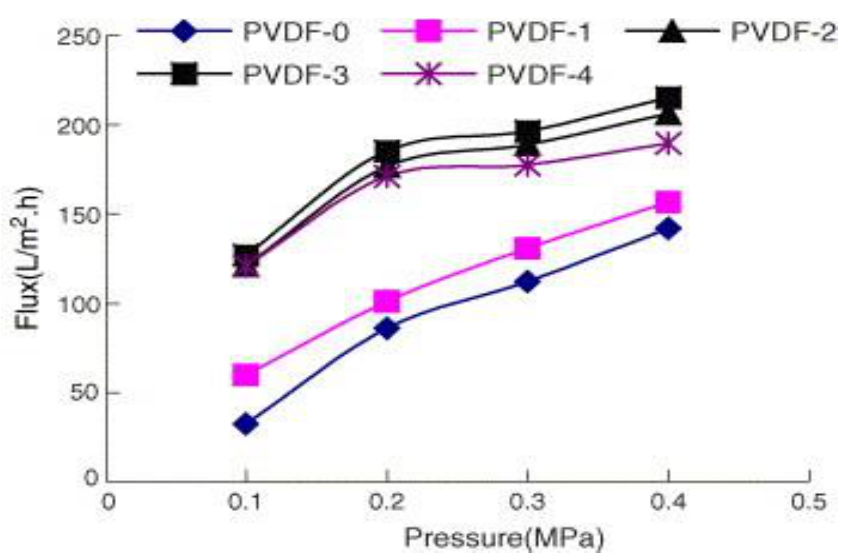
Figure 3. Distilled–H 2 O fluxes of membranes having different compositions of nano-sized Al 2 O 3 particles. Reprinted with permission from [69]. Copyright (2006) Elsevier B.V.